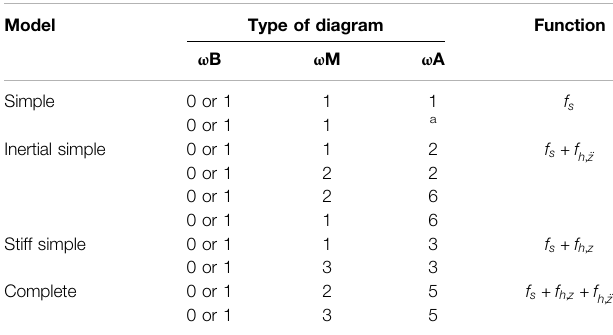
TABLE 9 | Rules for modeling the p diagrams. ω A Model Type of diagram